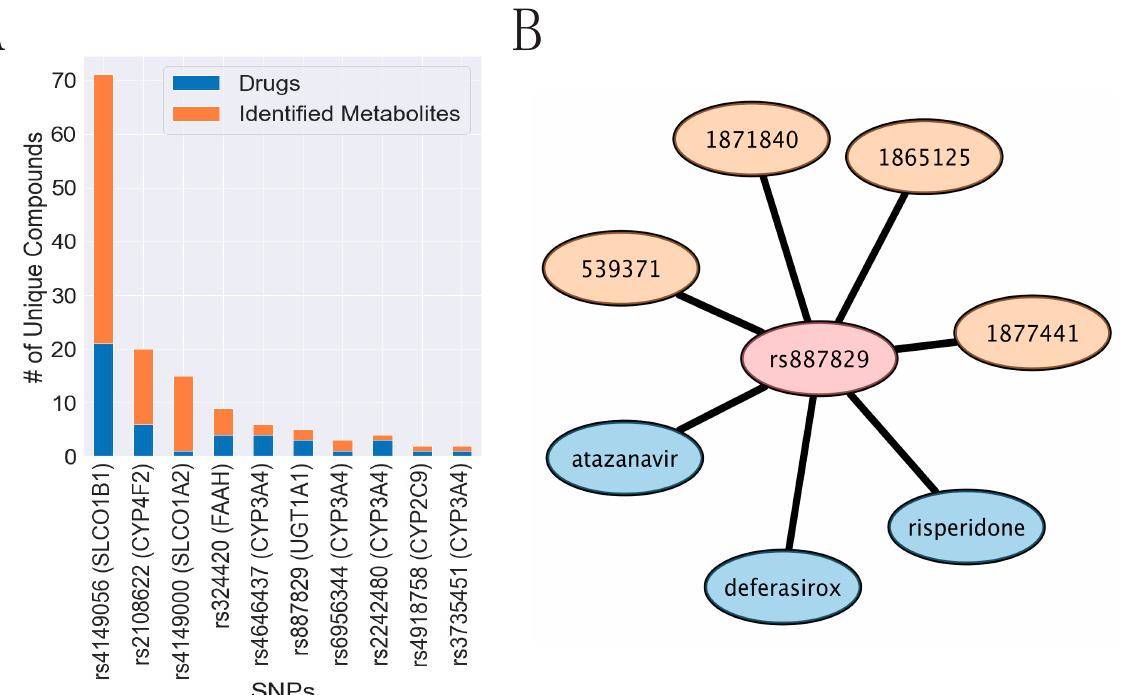
Figure 9. Some SNPs in ADME genes are involved in the regulation of both drugs and endogenous metabolites. ( A ) Certain SNPs are associated with levels of multiple identified metabolites in our study and with several drugs from other independent studies. Rs4149056, an SNP that impacts the function of SLCO1B1, is the most frequent SNP with respect to metabolites and drugs. ( B ) rs887829 ( UGT1A1 ) is an example of an SNP that is associated with three different drugs and identified metabolites that are all related to bilirubin (Supplementary Table S4). The SNP is shown as a pink node, the drugs are blue nodes, and the identified metabolite IDs are shown as orange nodes.